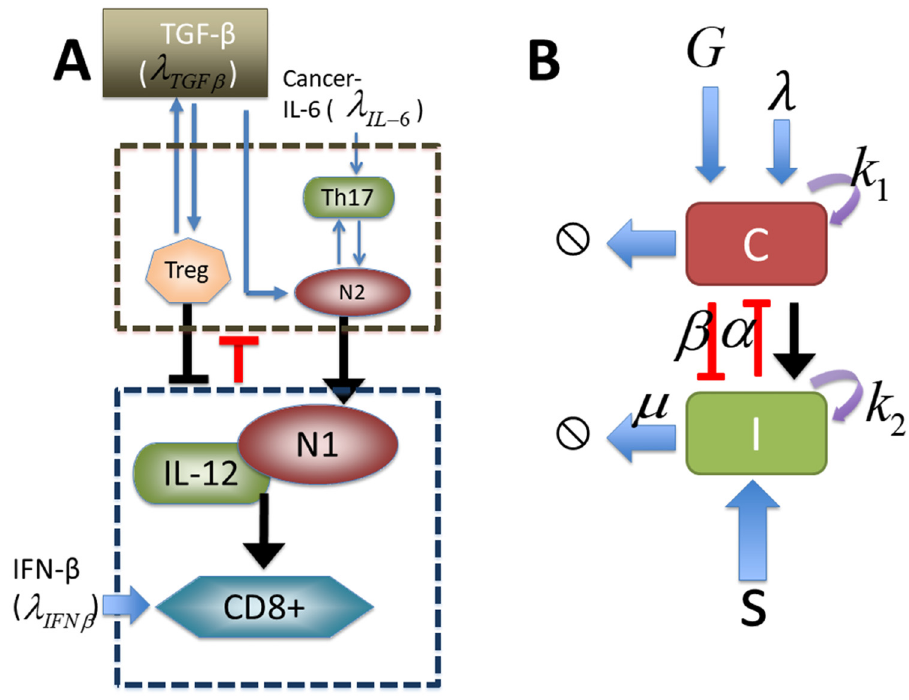
Fig 4. A schematic of our mathematical